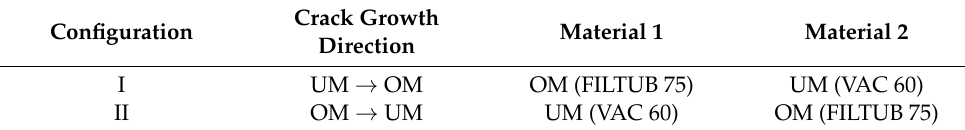
Figure 1. Schematic position of a mechanical notch in a bi-material welded SENB specimen. Table 1. Tensile mechanical properties.